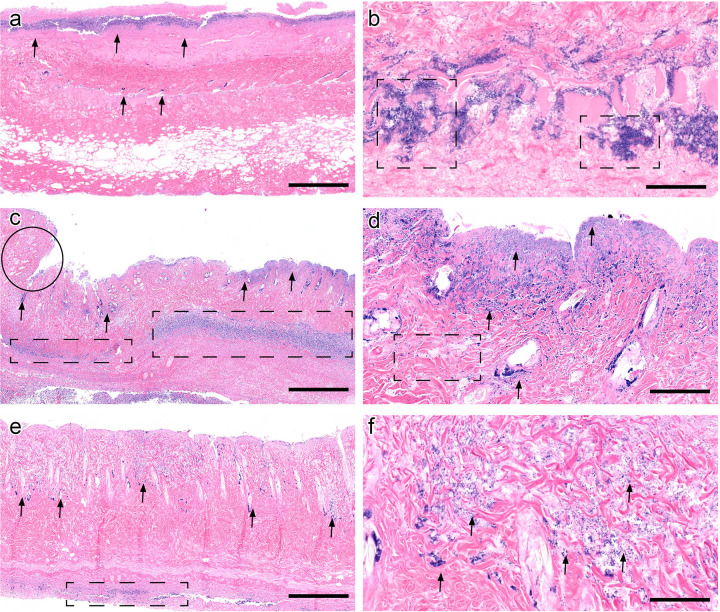
Histological evaluation of infected pressure ulcers in diabetic TALLYHO/JngJ mice.(a) Negative controls (vehicle alone) were characterized by dense thick carpets of superficial bacterial colonies (arrows) and full thickness necrosis, extending into the deep subcutis (image acquired at 2× magnification). Scale bar represents 1 mm. (b) On closer view, bacteria extend deep into the dermal tissue and are innumerable, forming thick aggregates (dashed boxes, image acquired at 20× magnification). Scale bar represents 100 μm. (c) Mupirocin-treated diabetic animals had a diminished bacterial burden, confined to the deep dermis and subcutis (arrows) surrounded by wound contraction (circle), indicating early wound healing, absent in negative controls. Inflammation extends deep into the subcutaneous tissue (dashed boxes) in contrast to untreated controls (image acquired at 2× magnification). Scale bar represents 1 mm. (d) On closer view, bacteria are less numerous and form small clusters compared to negative controls and collagen fibers are visible (dashed box). Scale bar represents 100 μm. (e) Ebselen-treated animals had a pronounced decrease in bacterial burden compared to the negative control, with few scattered aggregates in the deep dermis (arrows) and normal collagen fiber architecture in between. Inflammation was sparse compared to mupirocin treatment and present only at the deep tissue margin, indicating tissue clearing and early wound healing (dashed boxes) (image acquired at 2× magnification). Scale bar represents 1 mm. (f) Bacteria are sparse and markedly decreased compared to the negative control, with few colonies in between collagen fibers and occasionally forming clusters (arrows) (image acquired at 20× magnification).